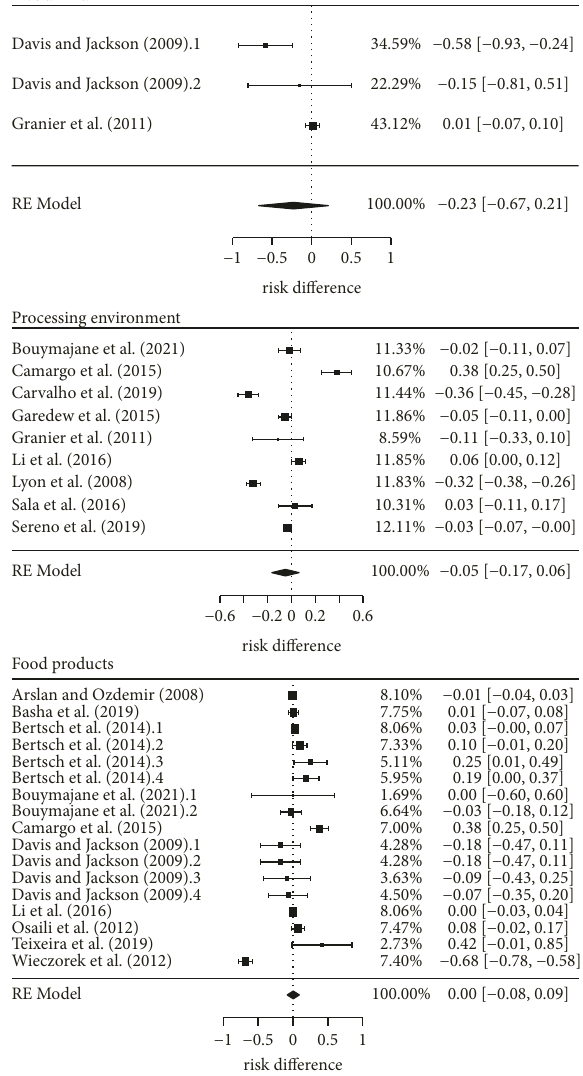
Figure 7: Risk difference of antimicrobial resistance to first- and second-line drugs in Listeria monocytogenes by source of